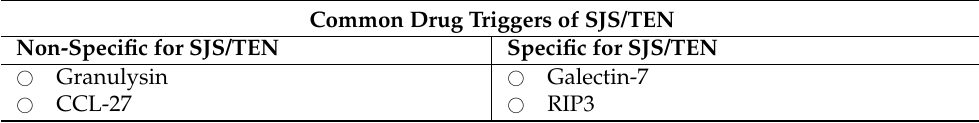
Table 7. Potential Biomarkers for the Diagnosis of SJS/TEN Common Drug Triggers of SJS/TEN Non-Specific for SJS/TEN Specific for